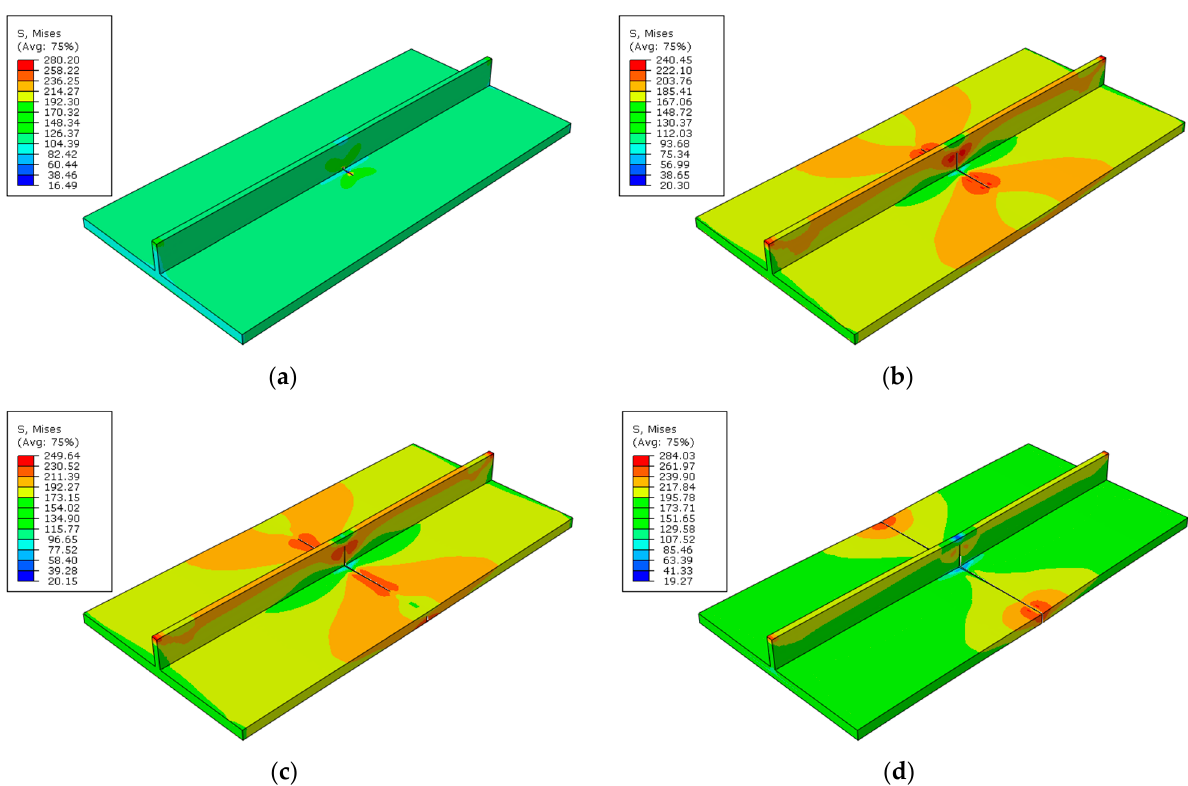
Figure 11. Stress contour plots for uniaxial tensile model; S is the displacement load under each state after conversion; ( a ) S = 0.234 mm; ( b ) S = 0.370 mm; ( c ) S = 0.379 mm; ( d ) S = 0.391 mm. (Unit: MPa.) The variation of the reaction force (RF) with time is depicted in Figure 12. It is concluded that when the crack of the bottom plate expands, the reaction force is linear with displacement load. When the bottom plate is completely damaged, the reaction force drops sharply, and the maximum reaction force is found as 441.31 kN. Until the stiffened plate breaks, and the reaction force reduces to 0.